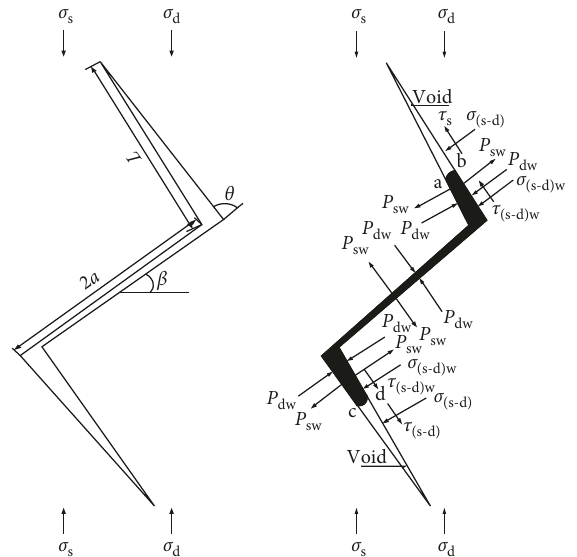
Figure 9: Pressure at the crack surface caused by free water under coupled static-dynamic